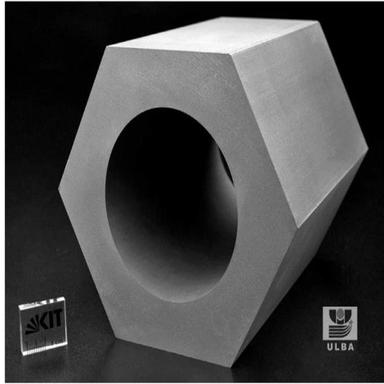
Hexagonal TiBe12 block after final machining.